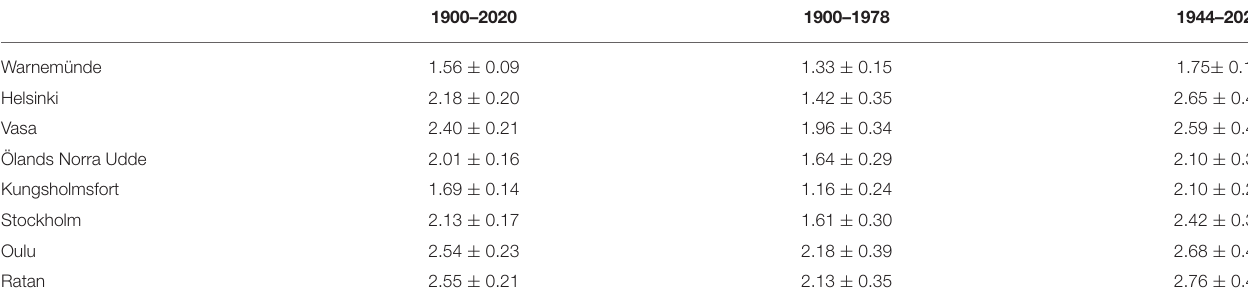
TABLE 1 | Rate of sea level rise (mm/year) for three different periods each of which embraces the warming hiatus